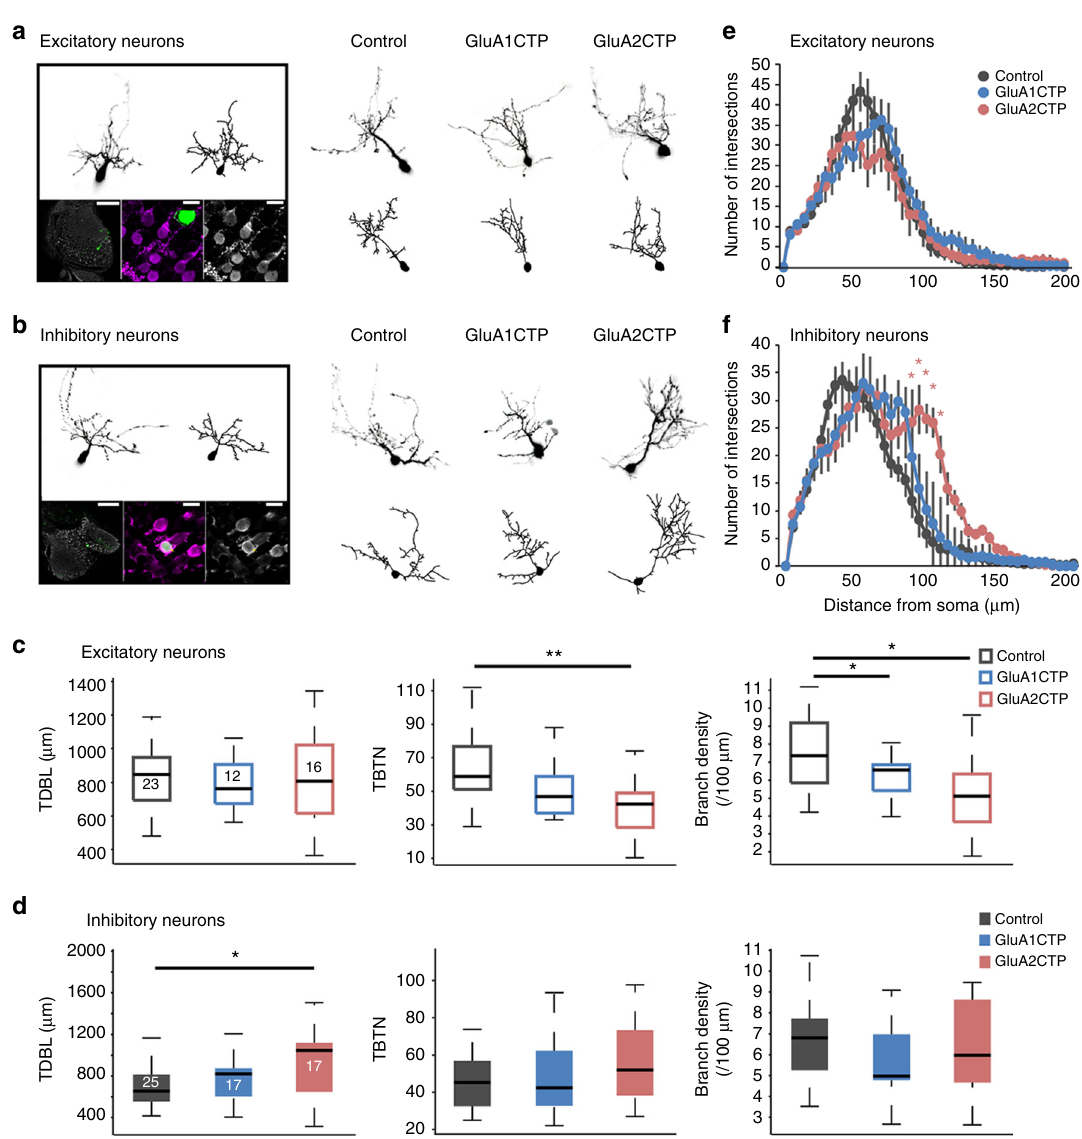
Fig. 3 GluACTPs differentially affect dendritic arbor growth in excitatory and inhibitory neurons. a , b Representative images of excitatory ( a ) and inhibitory ( b ) neurons. Left panel: Example of the live image and reconstructed full dendritic arbor of an individual neuron (top). Post hoc GABA immunolabeling (bottom) of the same neuron. Green, GFP; gray/magenta, GABA. Scale bar: left 100 μ m; middle and right 10 μ m. Right panel: Representative live images (top) of inhibitory neurons expressing GFP only (control), GluA1CTP, or GluA2CTP, and reconstructed complete dendritic arbors (bottom). c , d Summary data of total dendritic branch length (TDBL), total branch tip number (TBTN), and branch density control, GluA2CTP- and GluA1CTP-expressing excitatory ( c ) and inhibitory ( d ) neurons. * P < 0.05, Kruskal – Wallis test with post hoc Mann – Whitney U test. Number of neurons in each group is shown in the graph. e , f Sholl analysis: neither GluA1CTP nor GluA2CTP affected dendritic arbor branching pattern in excitatory neurons ( e ). GluA2CTP but not GluA1CTP signi fi cantly increased branch density distal to the soma in inhibitory neurons ( f ) compared to controls. * P < 0.05, ** P < 0.01, Kruskal – Wallis test with post hoc Mann – Whitney U test pooled population of inhibitory neurons showed no difference in Application of unsupervised cluster analysis based on Δ TBTN dendritic arbor plasticity between dark and STVE in controls in response to STVE versus dark clustered control inhibitory ( Δ TDBL, p = 0.38, Δ TBTN, p = 0.59) or GluACTP-expressing neurons into two evenly sized subpopulations, called Group I and neurons (GluA1CTP: Δ TDBL, p = 0.06, Δ TBTN, p = 0.48. Group II neurons (Fig. 5a, Group I: n = 14; Group II: n = 16). GluA2CTP: Δ TDBL, p = 0.96, Δ TBTN, p = 0.92, Wilcoxon test). Group I and Group II neurons displayed experience-dependent The magnitude of structural responses to either dark or STVE structural plasticity with opposite valence, accounting for the lack was not different between GluACTP-expressing and control of experience-dependent plasticity in the pooled population neurons (Fig. 4d). By contrast, plotting dendritic arbor growth (Fig. 4c). The plasticity pro fi le of Group I inhibitory neurons was rates over 4 h in STVE versus dark for individual neurons similar to excitatory neurons, retracting dendrites in the dark and demonstrates that GluACTP expression disrupted the inverse extending them in STVE. The plasticity pro fi le of Group II correlation between the valence of structural plasticity in dark inhibitory neurons was the opposite, extending dendrites in the and STVE observed in control inhibitory neurons (Fig. 4e). dark and retracting them in STVE (Fig. 5a). We applied the same NATURE COMMUNICATIONS| (2018) 9:2893 |DOI: